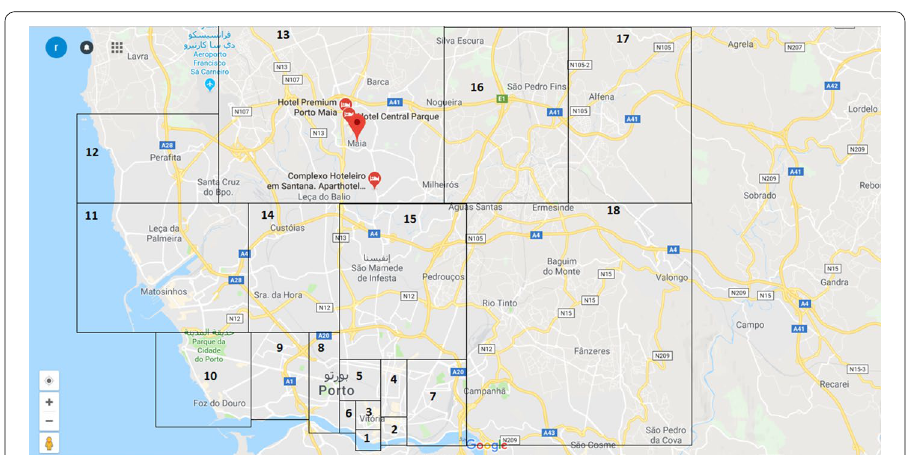
Fig. 2 Porto city districts as drawn in Google